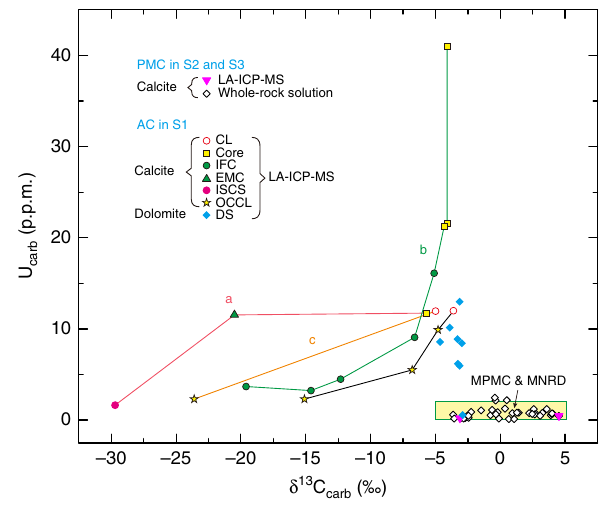
Figure 3 | A cross-plot of d 13 C carb and U carb data for the Yindushan section. Lines a, b and c correspond to the three samples shown in Fig. 2. The direction of the authigenic calcite growth sequence, generally from the centre of the core/central layer to the outside edge of the cement fringe, is from right to left for each line. S1, S2 and S3 represent three stratigraphic intervals shown in Fig. 1. AC, authigenic carbonates; CL, central layer; DS, dolomitic shale; EMC, equigranular microcrystalline calcite; IFC, isopachous fibrous calcite; ISCS, irregular-stacked calcite spar; MNRD, modern non- skeletal replacement dolomites; MPMC, modern primary marine calcites; OCCL, outward-coarsening calcite laminae; PMC, primary marine